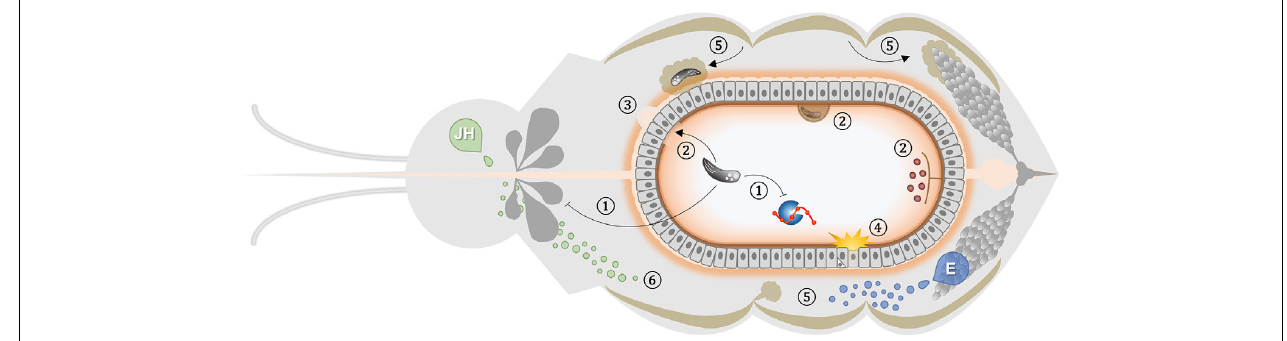
FIGURE 1 | Generic representation of non-immune elements that affect vector-pathogen interaction. The scheme depicts a frontal plane of a blood-feeding insect showing the relative position and interactions of the different non-immune players involved in diverse parasite-vector associations. Organ and cell sizes are not up to scale. (1) Parasites can manipulate feeding rate and digestion activity of the host (Stierhof et al., 1999; Sant’Anna et al., 2009). (2) Peritrophic matrix regulates intestinal infection, requiring parasite escape to establish invasion (Huber et al., 1991; Rose et al., 2020); allowing parasite anchoring to ectoperitrophic space (Pimenta et al., 1997; Zhang et al., 2015); and compartmentalizing microbiota to ensure immune ignorance of the epithelium (Weiss et al., 2014). (3) Blood-feeding-induced microperforations in the basal lamina support pathogen dissemination (Kantor et al., 2018; Armstrong et al., 2020). (4) Rupture of the peritrophic matrix barrier activates ROS generation that triggers an epithelial response to infection (Oliveira et al., 2011a; Taracena et al., 2018). Juvenile Hormone (JH) and Ecdysone (E) are key regulators of the physiological trade-off between reproduction and immunity. (5) Ovary ecdysone production exerts paramount effects such as fat body-induced provision of lipid molecules during vitellogenesis that can reduce the parasite-killing ability and support its development (Rono et al., 2010; Werling et al., 2019). (6) Juvenile hormone influence diverse physiological processes in the insect that can impact pathogen success such as ability to feed on blood, midgut remodeling, reproductive competency, gene expression regulation, lipid metabolism and immune response mounting (Clifton and Noriega, 2011; Zou et al., 2013; Roy et al., 2015; Kim et al., 2020).